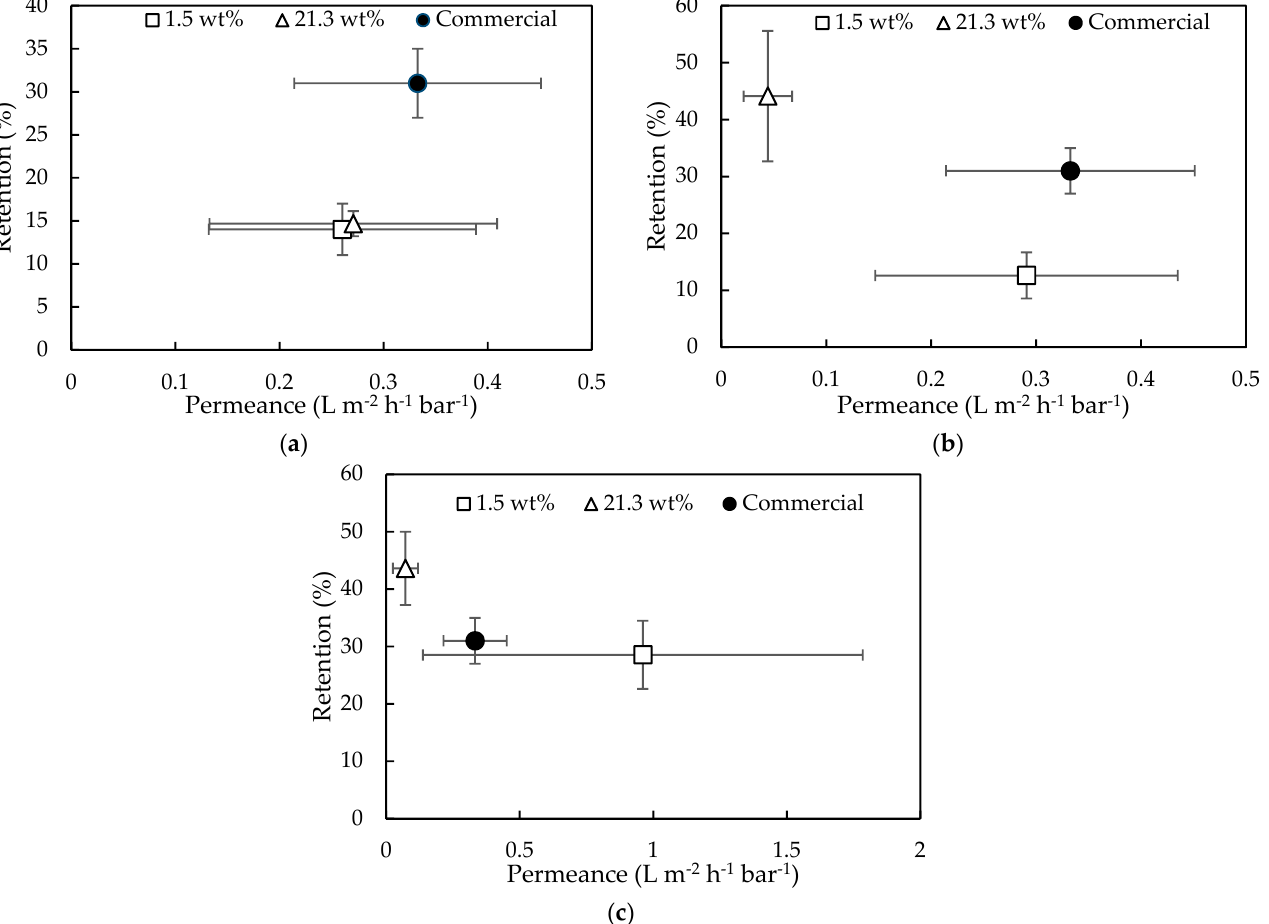
Figure 7. Water/ EtOH permeance and EA retention of GEA RO membrane (type AF) and membranes synthesized with IL containing 1.5 wt% and 21.3 wt% H 2 O, applying ( a ) 60 s, ( b ) 150 s, and ( c ) 300 s reaction time.